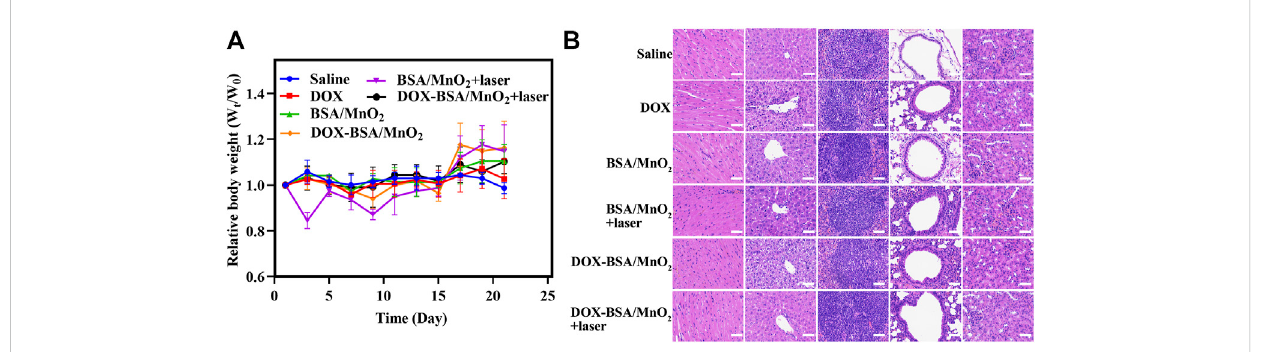
FIGURE 6 Biosafety evaluation. (A) The relative body weight alteration of MCF-7/ADR tumor-bearing nude mice following medications with various formulations; n = 3; (B) H&E staining photos of hearts; livers; spleens; lungs; and kidneys of MCF-7/ADR tumor-bearing nude mice after therapies; scale bar = 50 μ